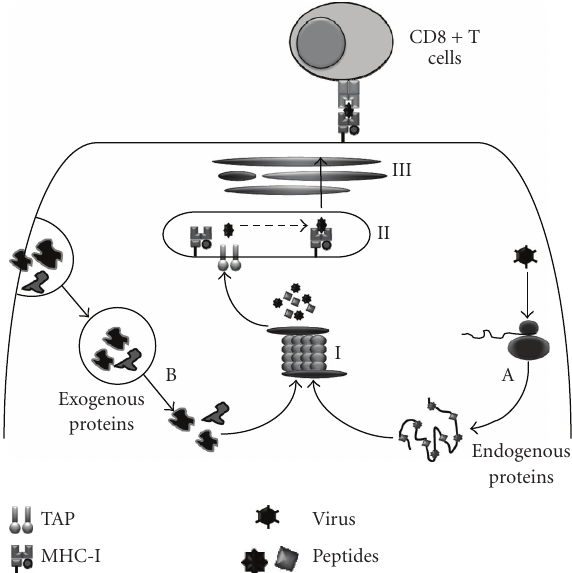
Figure 1: Antigen processing pathways. Direct presentation involves the processing of endogenously synthesized antigens (route A) by the proteasome (I) to break them down into smaller fragment (polypeptides) that are transported through the transporter associ- ated with antigen processing (TAP) into the endoplasmic reticulum (II) for loading onto newly synthesized MHC class I molecules. These peptide-loaded MHC class I molecules are then transported through the Golgi (III) to the cell surface for presentation to CD8+ T cells. Considering the major route for antigen cross- presentation (route B), exogenous antigens are internalized in the endosome/phagosome before they are released into the cytosol and degraded by the proteasome to be presented on MHC class I